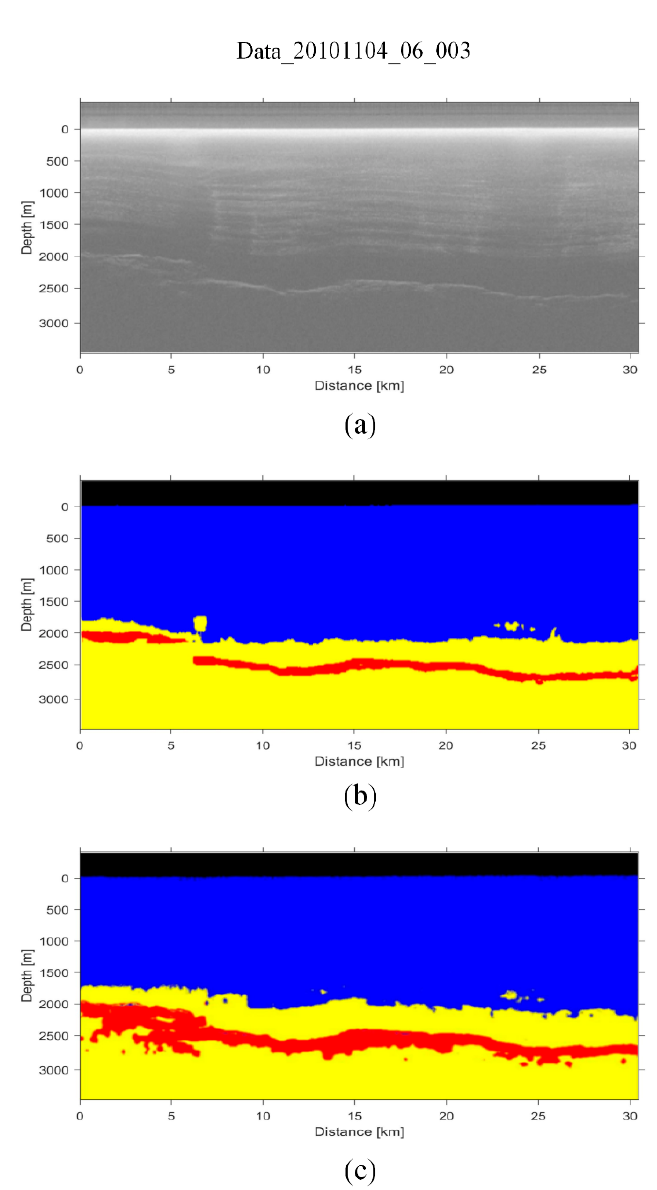
Figure 7. Examples of ( a , b ) radargrams and ( c , d ) corresponding classification maps generated with the presented network. In the classification maps, each class corresponds to a different color: free space (green); layers (yellow); bedrock (red); noise and EFZ (black).